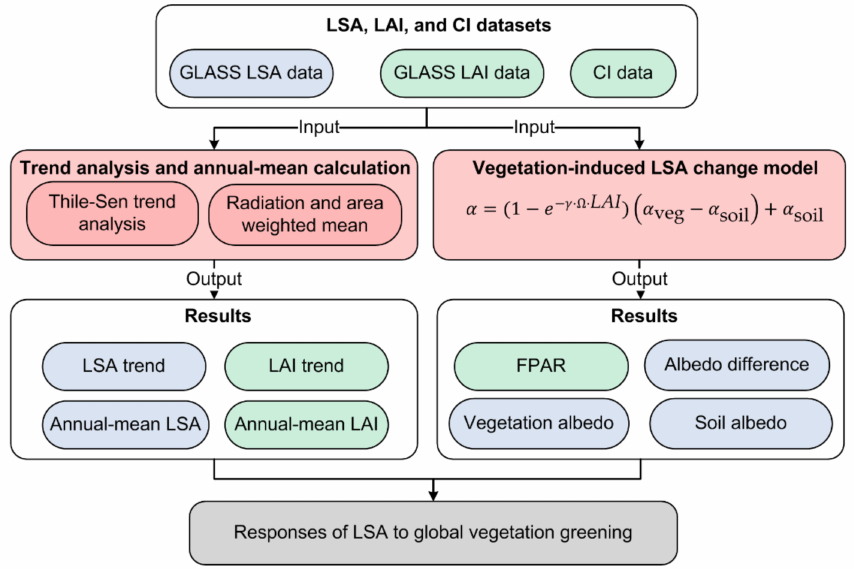
Figure 1. Flowchart for analyzing the responses of the land surface albedo (LSA) to global vegetation greening using Global Land Surface Satellite (GLASS)